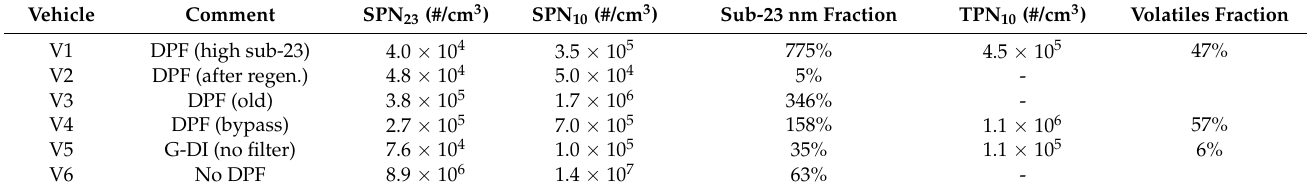
Table 4. Mean concentrations and sub-23 nm and volatile